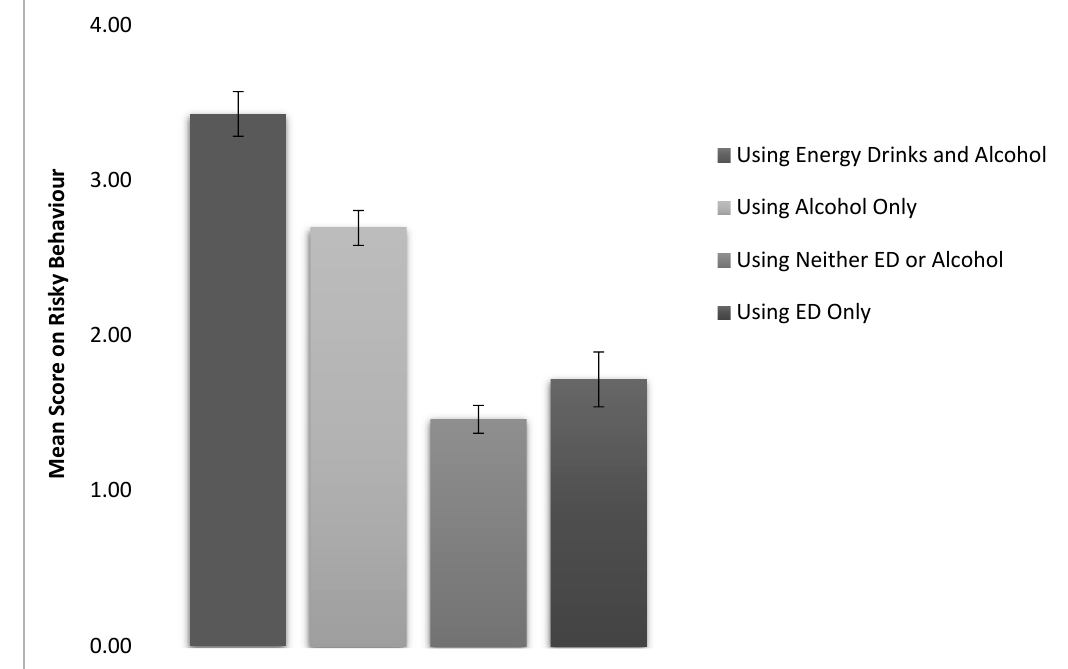
Figure 3. Mean scores for risky behavior based on use of drinks.